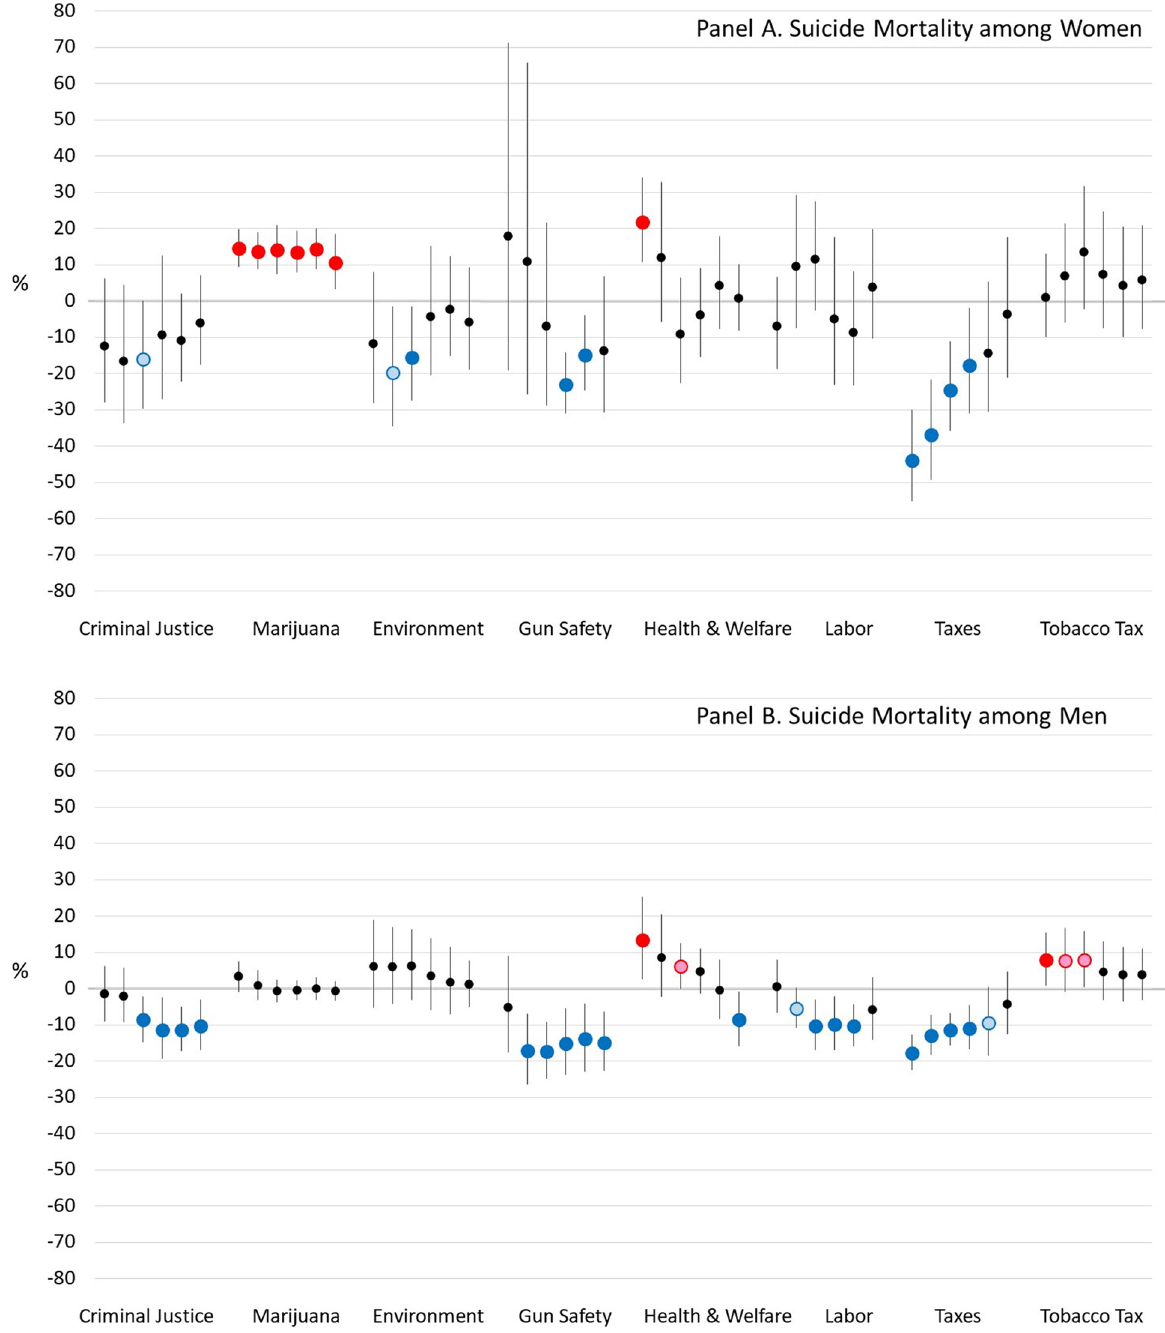
Fig 5. Estimated percent difference in suicide mortality rates when a U.S. State’s policy liberalism score is 1 versus 0, for various lag times between the policies and mortality. Notes : Blue dots mean a more liberal version of the policy is associated with lower mortality and red dots mean a more conservative version is associated with lower mortality. Dark blue and red dots indicate that the association is significant at α < 0.05, while light blue and red dots indicate that it is significant at α < 0.10.